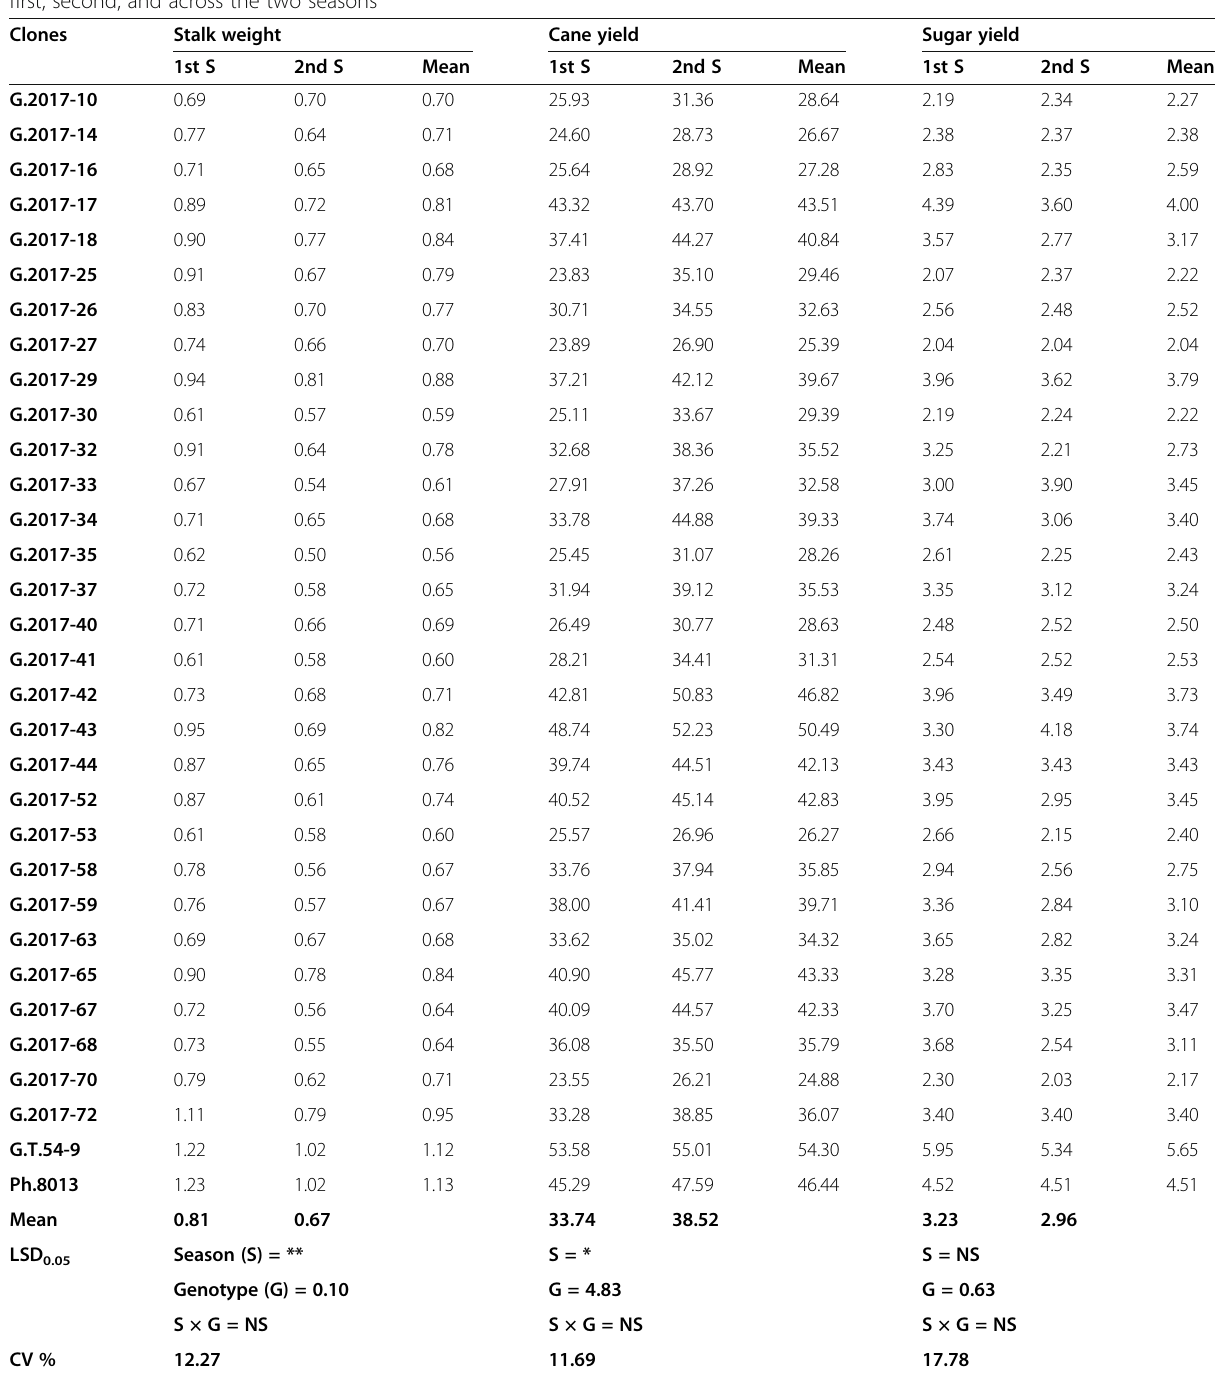
Table 5 Mean performance of 30 sugarcane genotypes and two check cultivars for stalk weight, cane yield, and sugar yield in the first, second, and across the two seasons Clones Stalk weight Cane yield Sugar yield 1st